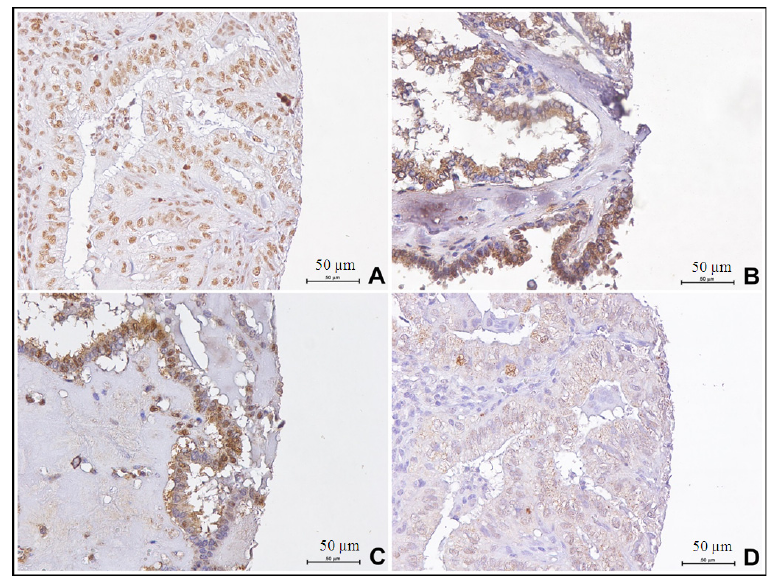
Figure 4. Paralogous group 13 HOX genes IHC expression in metastatic thyroid samples: ( A ) HOX A13 expression (40×); ( B ) HOX B13 expression (40×); ( C ) HOX C13 expression (40×); ( D ) HOX D13 expression